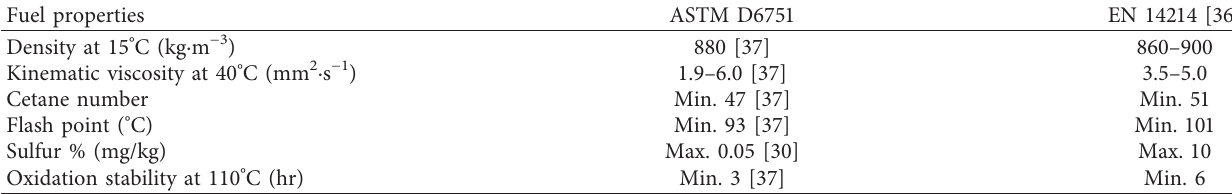
Table 4: Standard specifications for biodiesel.